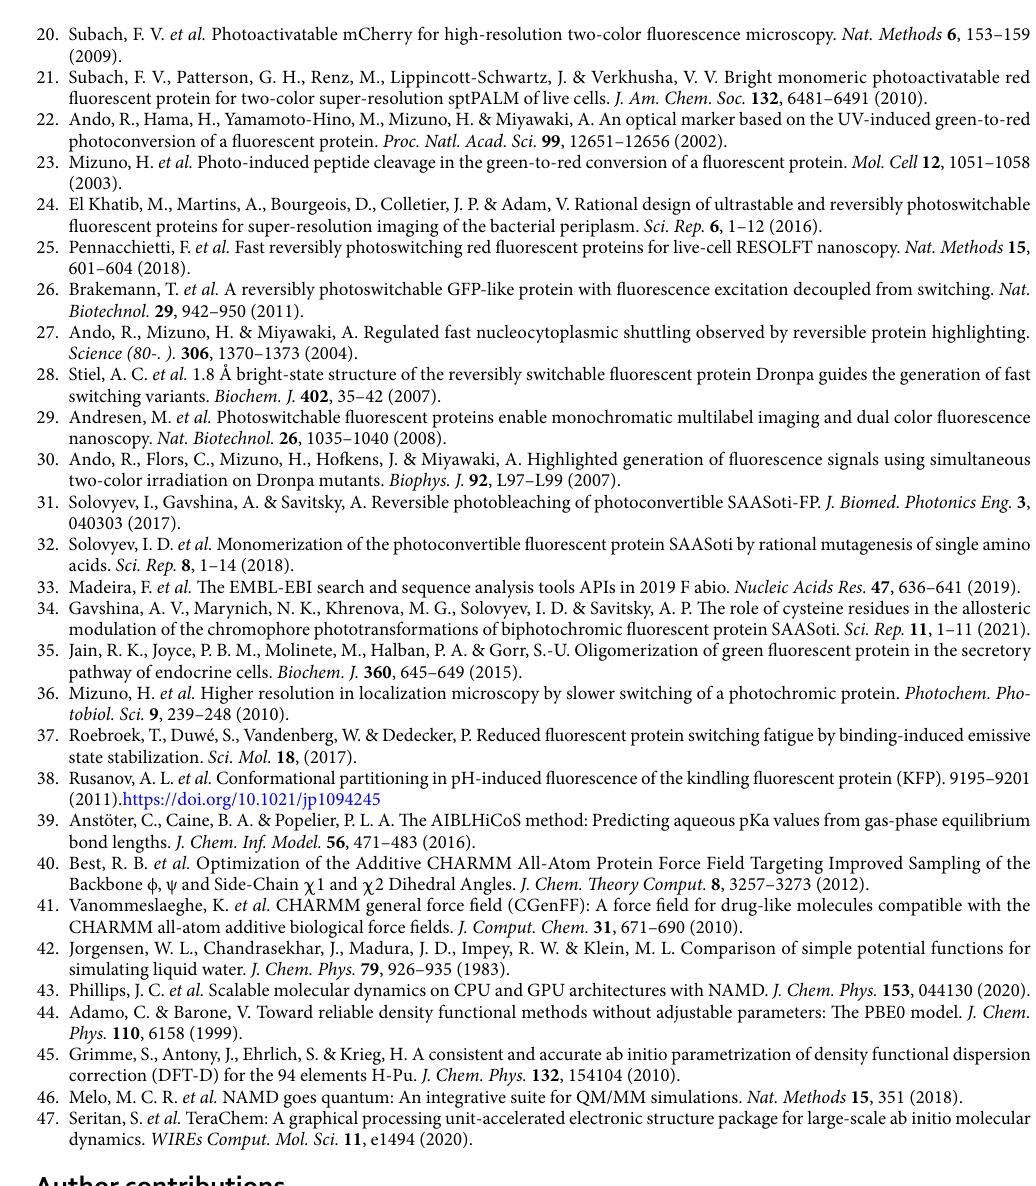
Table 5. I.D.S.: setup for studying phototransformations, design of experiments on phototransformations and data processing. A.P.S.: supervised the project. All authors discussed the data and contributed to the manuscript